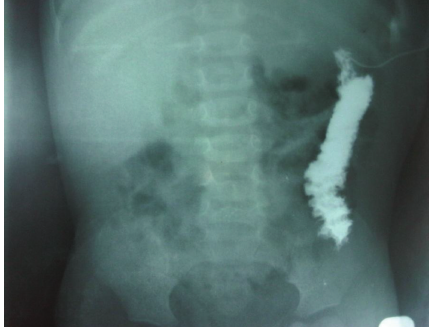
Figure 1: Fistulogram showing contrast emptying into the descend- ing colon.